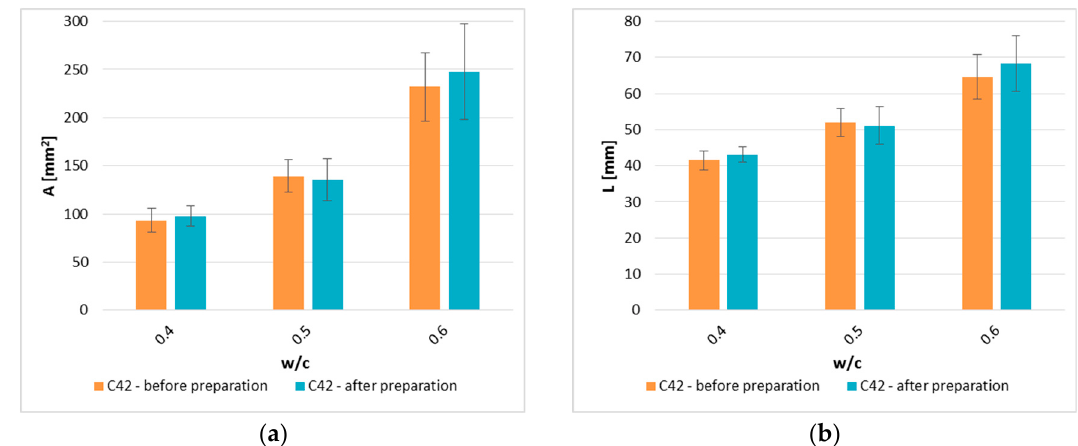
Figure 5. Comparison of the image analysis results between samples of the C42 series that have not and have been subjected to the surface preparation: ( a ) A —the cluster average area; ( b ) L —the cluster average perimeter.